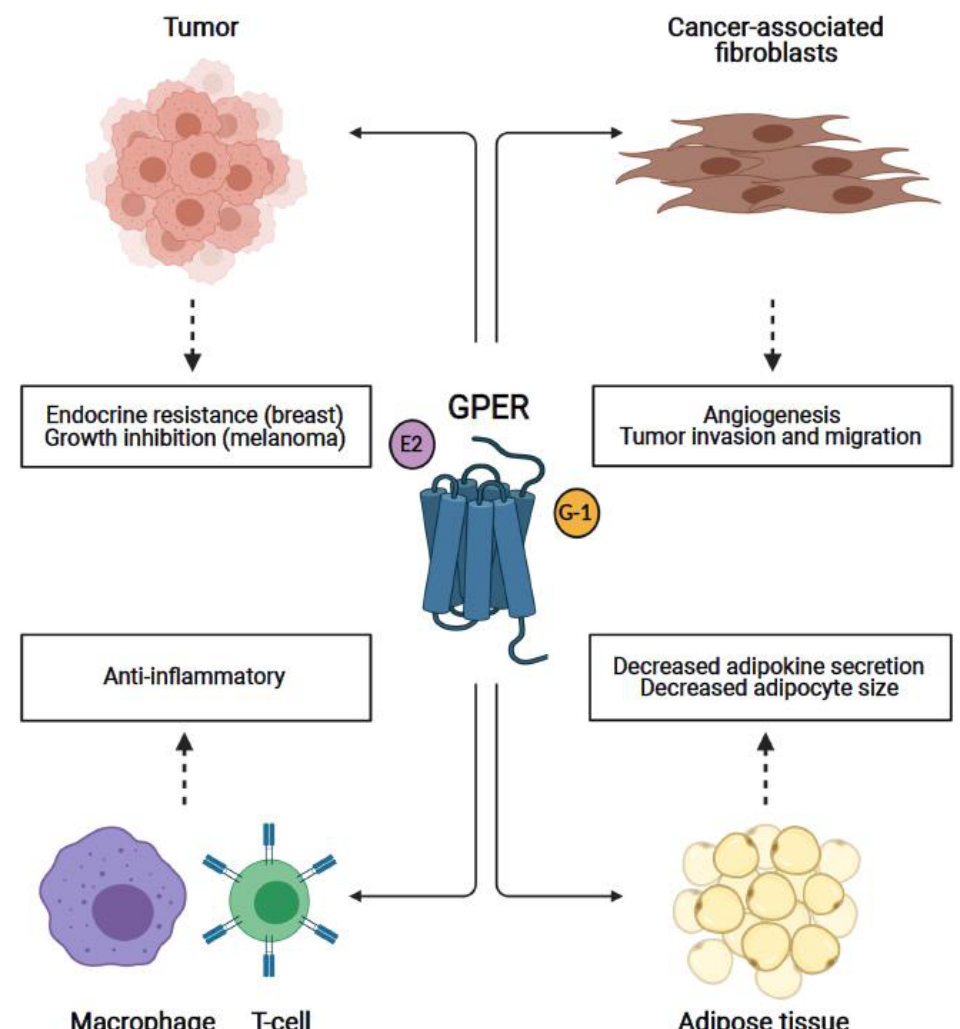
Figure 1. Effects of G protein coupled estrogen receptor (GPER) signaling in multiple tissue types that affect carcinogenesis. GPER signaling induces various responses in different tissue types that can promote or inhibit tumor growth and progression. In estrogen receptor (ER)-positive breast cancers, GPER activation may contribute to the development of endocrine resistance. However, in a melanoma setting, GPER signaling (through G-1 activation) inhibits tumor growth and increases the efficacy of anti-programmed cell death protein-1 (PD-1) immunotherapy. In cancer-associated fibroblasts (in breast cancer), GPER signaling leads to a pro-tumorigenic environment through increased secretion of angiogenic (e.g., vascular endothelial growth factor (VEGF)) and migratory (e.g., connective tissue growth factor (CTGF)) factors that pro-